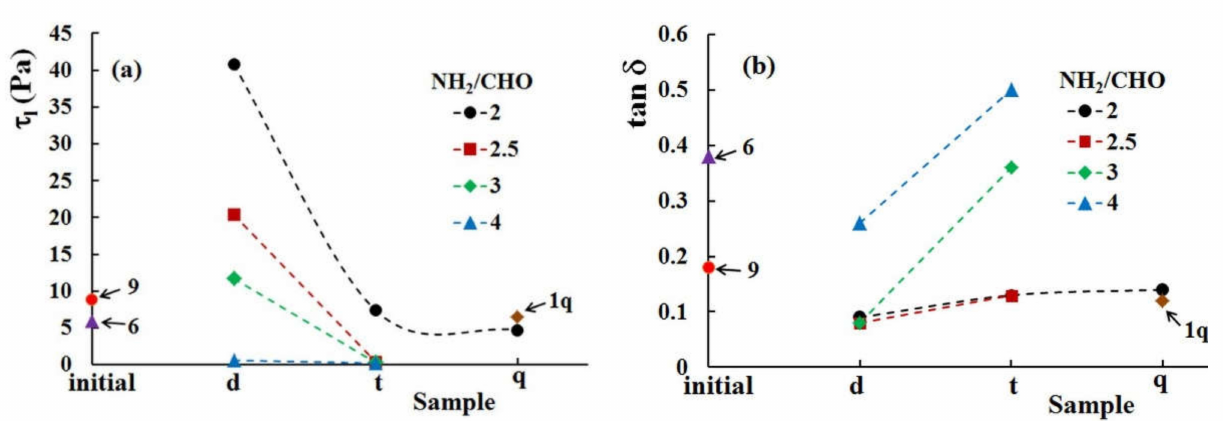
Figure 8. Effect of water content in hydrogel and NH 2 /CHO ratio on ( a ) limiting shear stress, τ l of LVR, and ( b ) tan δ .